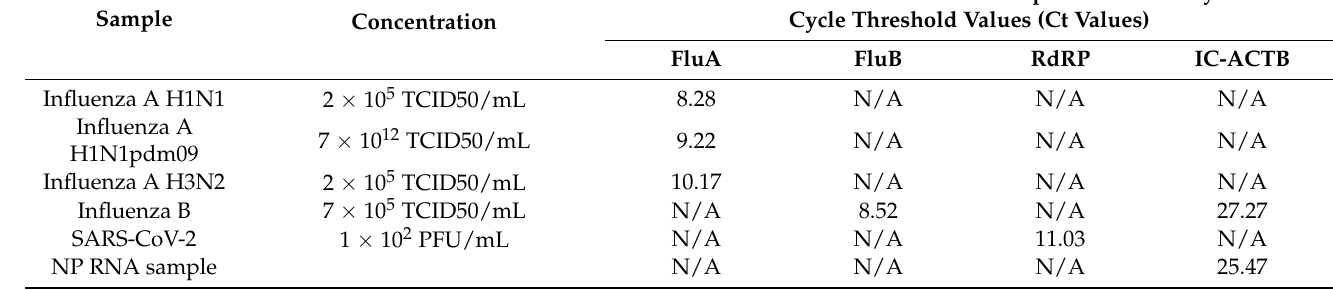
Table 3. Performance of FluA/FluB/SARS-CoV-2 multiplex LAMP assay for influenza A